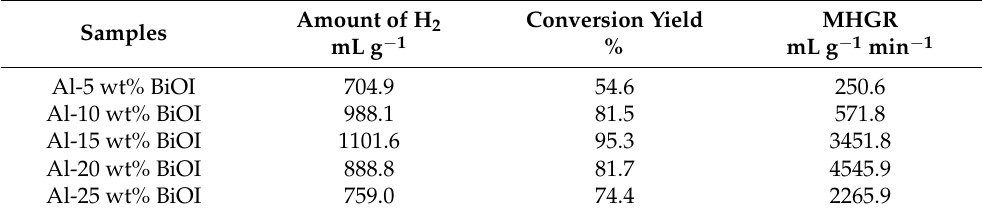
Table 2. Hydrogen generation performances of Al- x wt% BiOI at 298.15 K.